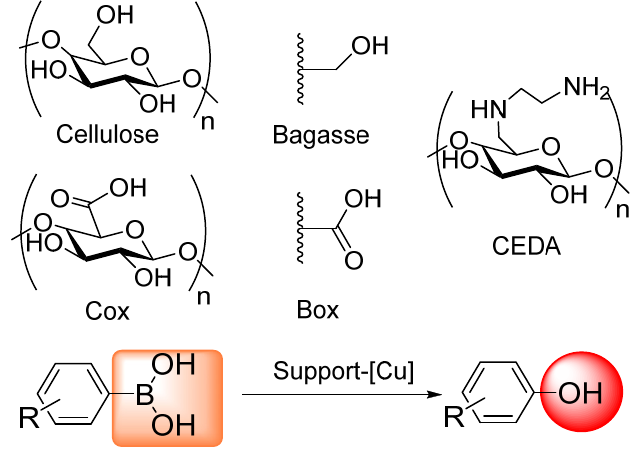
Figure 1. Bio-based solid supports: raw cellulose, oxidized cellulose (Cox), raw sugarcane bagasse, oxidized sugarcane bagasse (Box), 6-deoxy-6-aminoethyleneamino cellulose (CEDA) and ipso -hydroxilation of boronic acids.